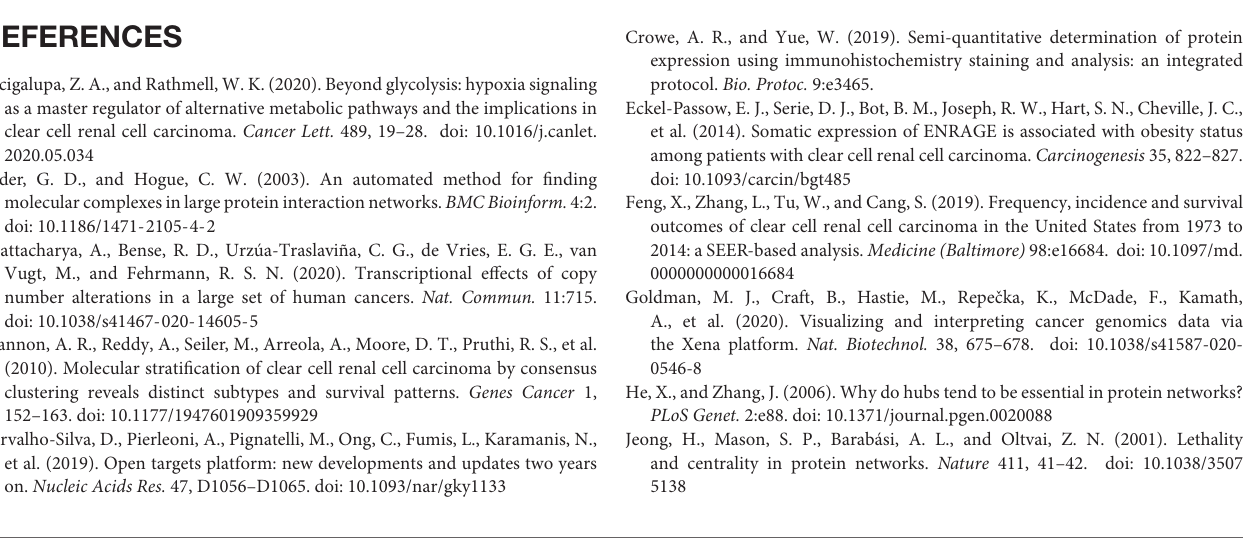
Supplementary Figure 1 | Volcano plots showing differentially expressed genes in each dataset. Red and green dots represent upregulated and downregulated genes respectively. Supplementary Figure 2 | GO term enrichment and KEGG pathway analyses of differentially expressed genes in different functional modules in PPI network. GO terms of module 1 (A) , module 2 (B) , module 3 (D) , and module 5 (G) . BP, biological process. CC, cellular component. MF, molecular function. KEGG pathway analyses of module 2 (C) , module 3 (E) , and module 5 (F) . Supplementary Figure 3 | AOX1 expression in ccRCC patient subgroups. No differences were observed between ccRCC patients subgrouped by pathologic stages (A) , metastatic states (B) , smoking history (C) , and histological grades (D) . n = 265, 55, 122, and 84 for stage I, II, III, and IV in (A) . n = 417 and 78 for M0 and M1 in (B) . n = 46 and 39 for non-smoker and smoker group in (C) , n = 14, 228, 206, 75, 242, and 281 for G1, G2, G3, G4, G1/G2, and G3/G4 in (D) . Supplementary Table 1 | Detailed information of ccRCC